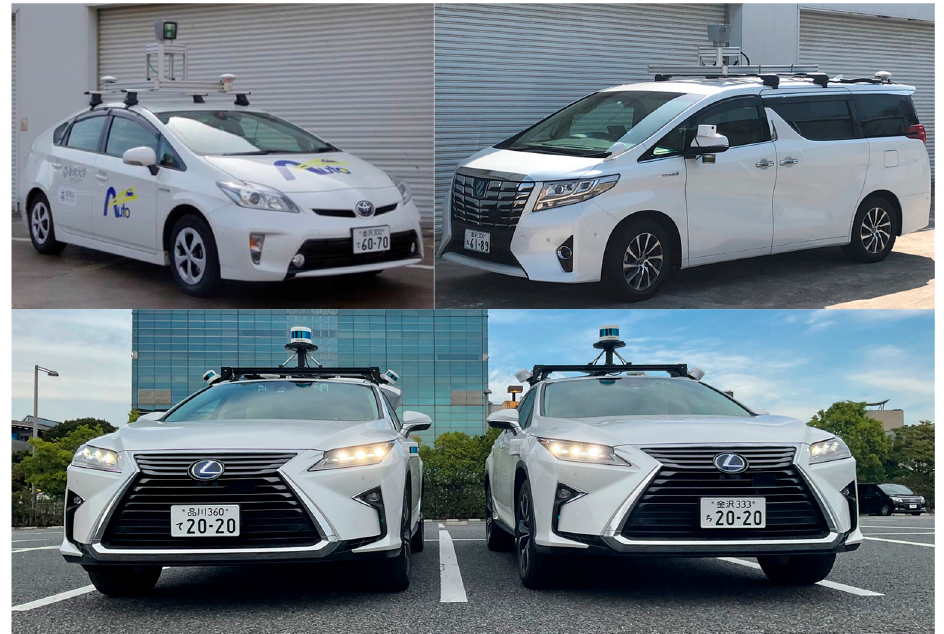
Figure 4. Experimental platforms with different sensor configurations. Prius with LIDAR HDL-64 S2 and Applanix PosLV 110 GIR, Alphard with LIDAR 64 and PosLV 220 and two identical Lexus cars with LIDAR VLS-128-AP and PosLV 220.